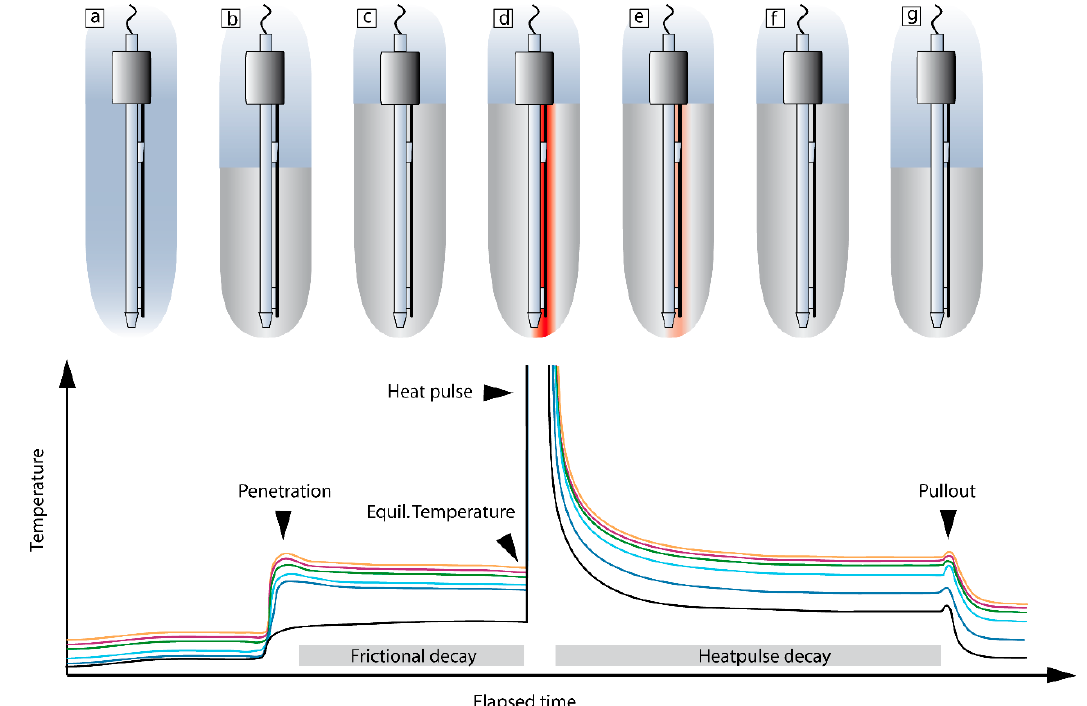
Figure 3. Temperature measurements and thermal conductivity estimate with a violin-bow heat flow probe. ( a ) Probe is lowered through the water column and ( b ) penetrates into the seabed, where frictional heat is generated. During the steady-time ( c ), the frictional heat dissipates, sediment temperatures equilibrate, and geothermal gradients are inferred from the sensor readings and the probe geometry. ( d ) A heat pulse rises sediment temperatures and from the recording of the thermal decay curve ( e-f ) thermal conductivities and diffusivities can be estimated. ( g ) Probe is pulled out of the sediment and retrieved back on board. The lower panel shows a typical temperature recording of six sensors exemplarily. Please note that the violin-bow configuration typically consists of a string with 21 sensors, but the lower graph shows only six sensor data curves. Sketch adapted and modified after [26].